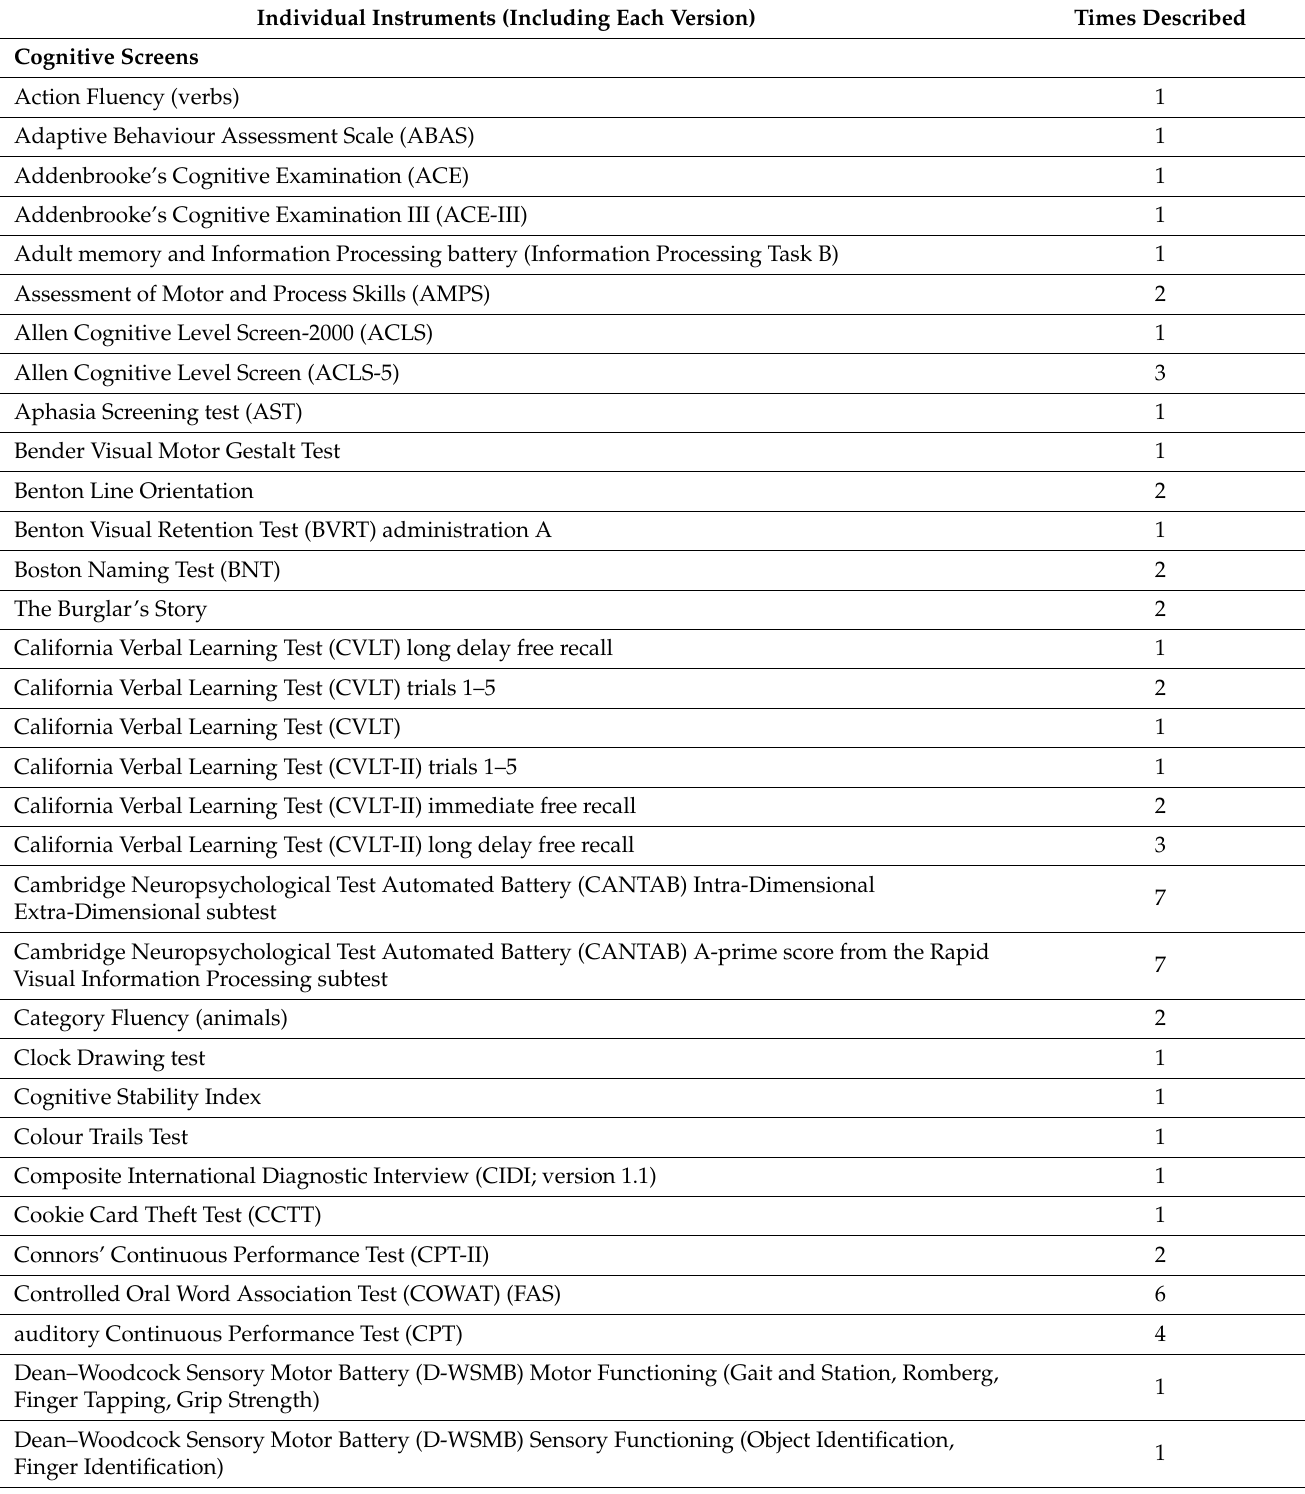
Table A3. Complete list of screening